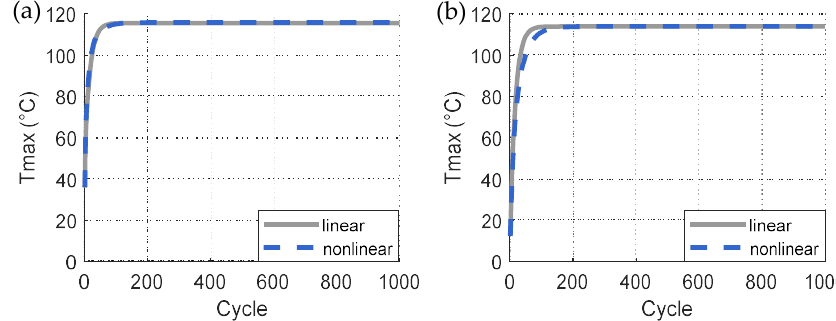
Figure 16. Comparison of maximum temperature with each cycle for s = 2 m between the linear and nonlinear thermal models: ( a ) the outer surface of the concrete section and ( b ) the center line between two piles.